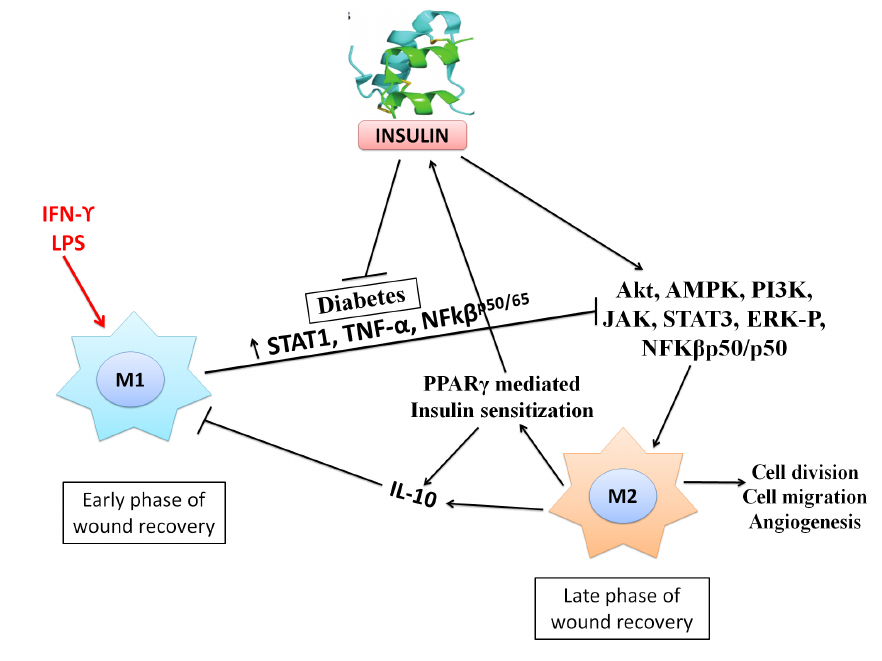
Figure 2: Effect of insulin in transition of M1 to M2 macrophages. In the presence of insulin the expression of M2 macrophages Akt, PI3K, AMPK, PKC, HIF-α, STAT3, NFkβ P50/P50 , and ERK increases leads to anti-inflammatory response and help in wound